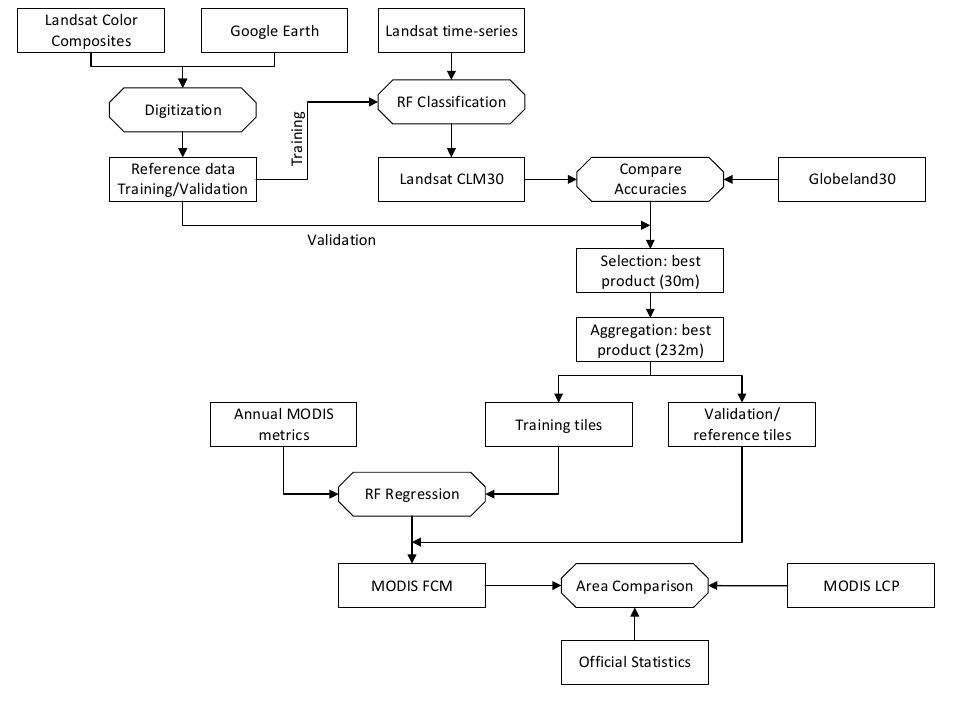
Figure 3. Flowchart of the methodological approach.